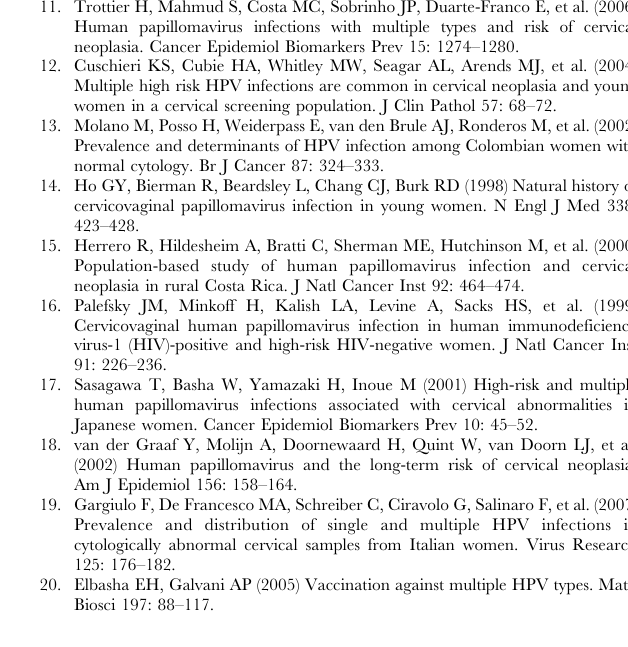
Table S1 Primer sequences used for HPV 56 and 66 PCR amplification. Table S2 Key parameters and assumptions of the different randomization models. Table S3 Significant 3 HPV type combinations. Table S4 Significant 4 HPV type combinations. Table S5 Number of times HPV types appeared in significant combinations. (DOC) Methods S1 Supplementary methods for statistical